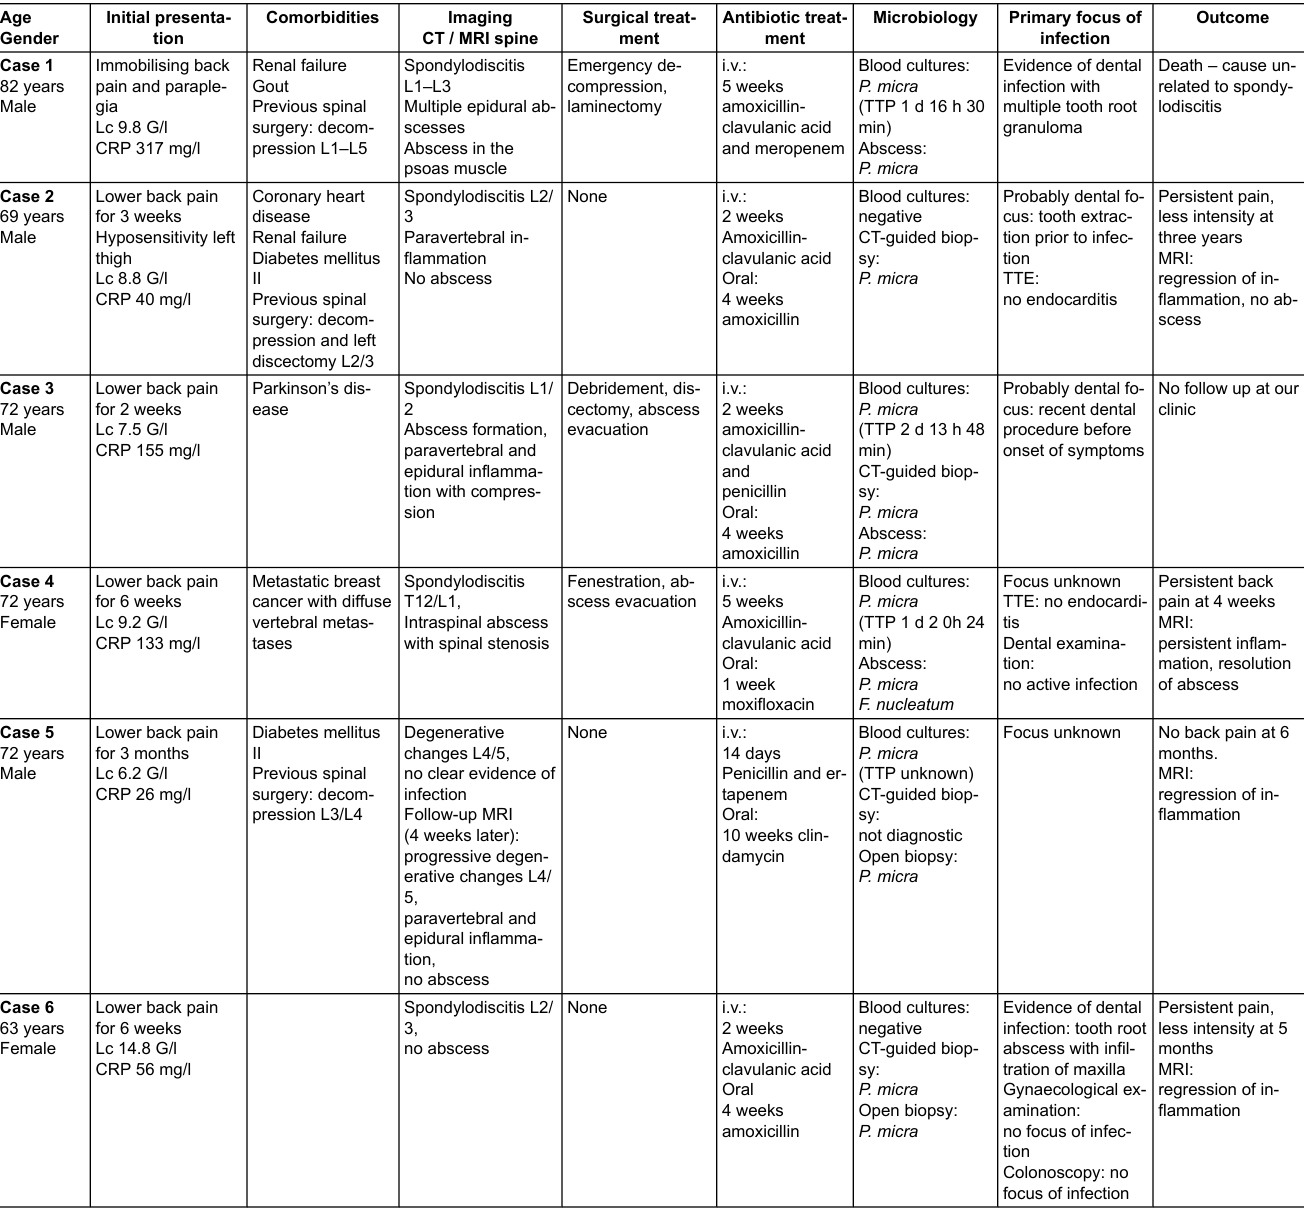
Table 1: Summary of